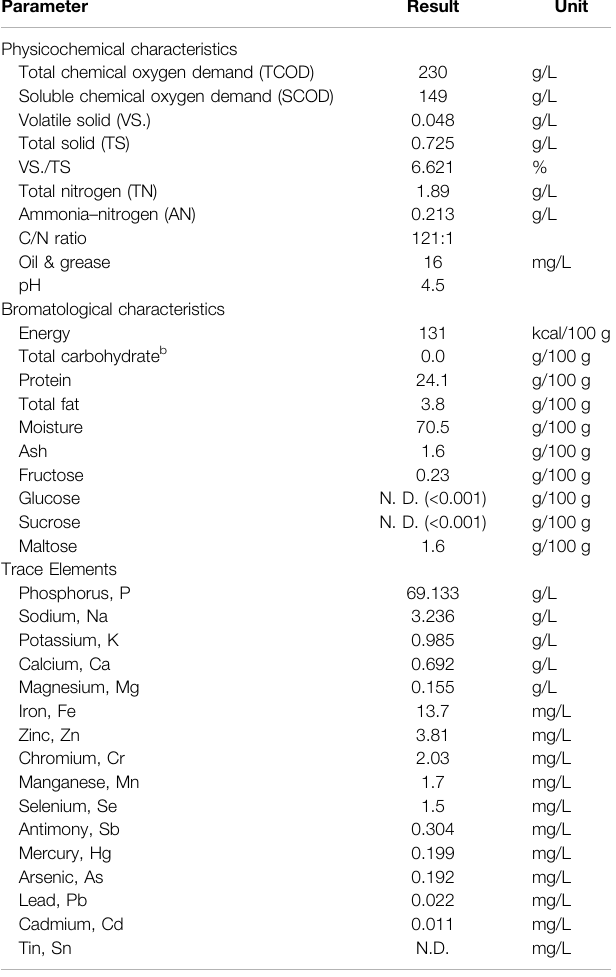
TABLE 2 | Characteristic of commercial Malaysian food waste.